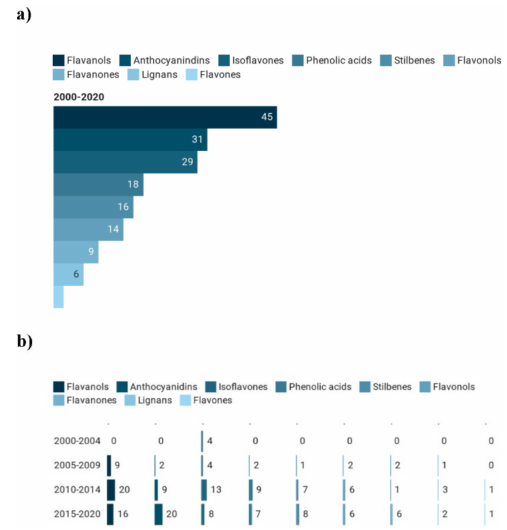
Figure 5. Main classes of pure polyphenols used in clinical trials ( a ) and their trend ( b